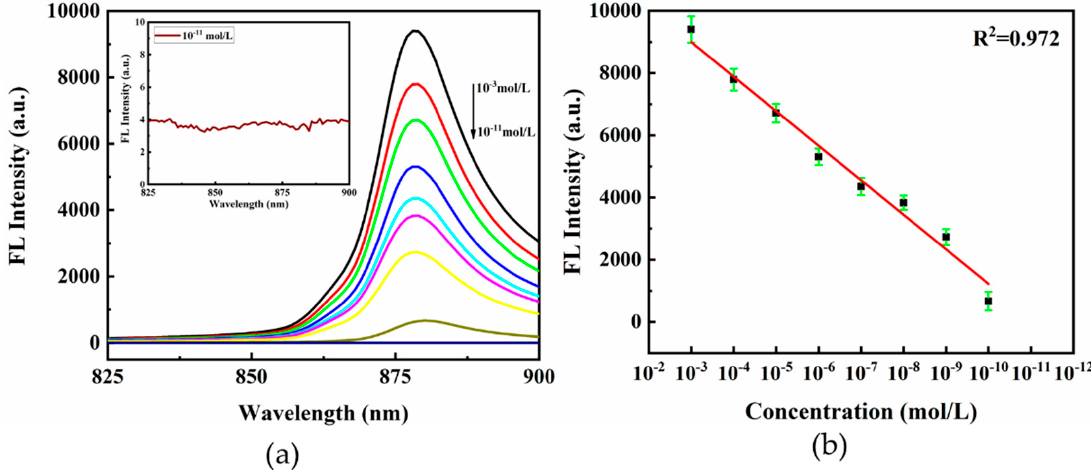
Figure 8. ( a ) Fluorescence spectra of CV at different concentrations (from 10 − 3 to 10 − 11 mol/L). Insets show the detailed view of fluorescence spectra of CV at 10 − 11 mol/L; ( b ) linear correlation of fluorescence intensities at 880 nm.